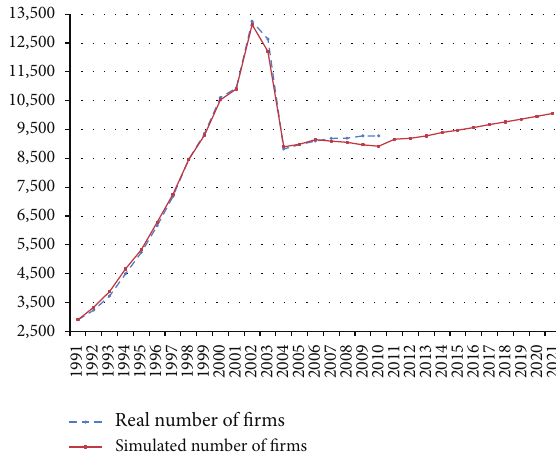
Figure 3: Comparison between simulated and actual numbers of contractors.